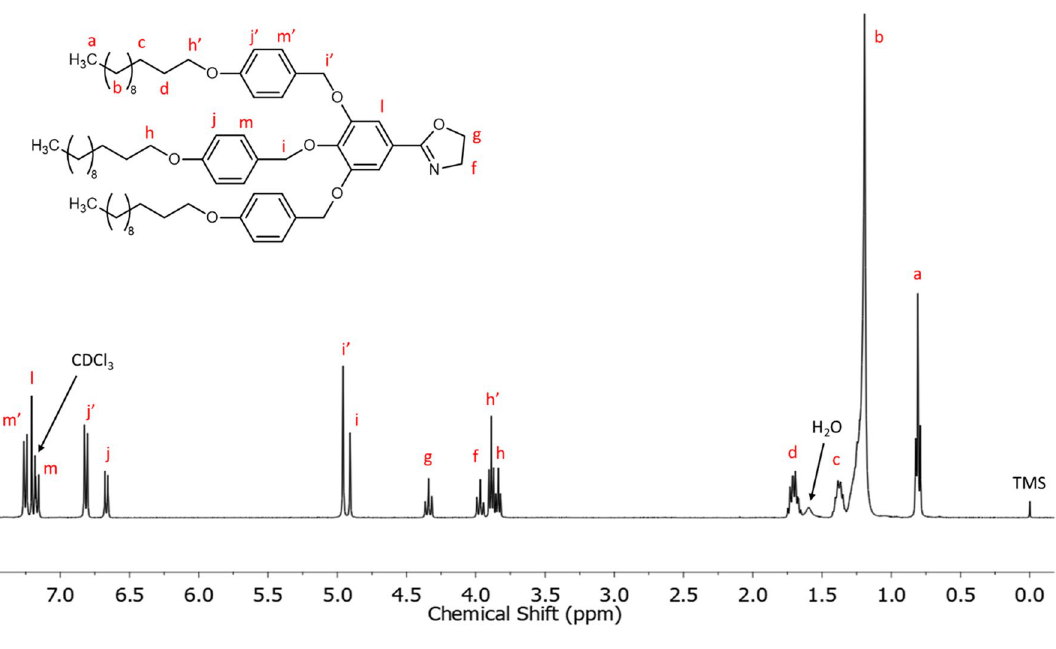
Figure 6. 1 H NMR spectrum in CDCl 3 of